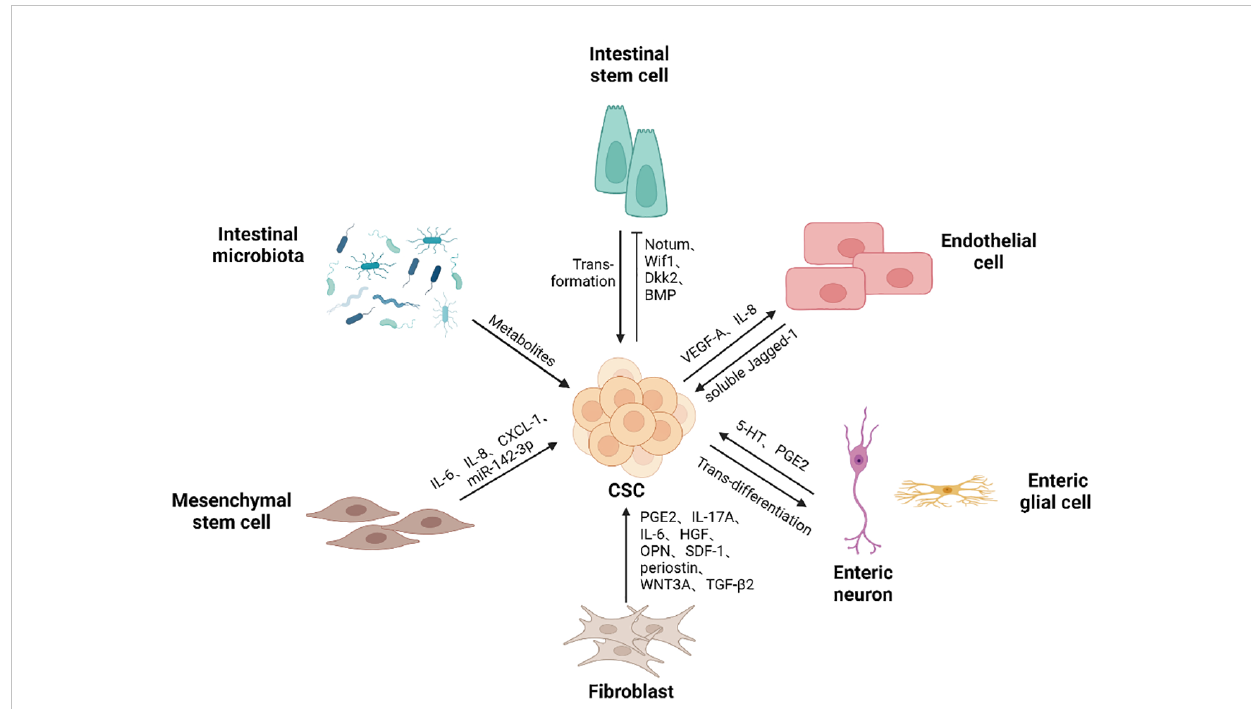
FIGURE 2 Colorectal CSCs niche components. Colorectal CSCs niche contains different types of cells and microbes, as well as the soluble substances they produce, supporting the self-renewal ability of cancer stem cells. Cancer stem cells can gain a competitive advantage over normal stem cells by promoting differentiation. Mutations drive intestinal stem cells to transform into cancer stem cells. Besides, colorectal cancer stem cells promote endothelial cell proliferation and migration, thereby participating in the generation of blood vessels. In addition, cancer stem cells give rise to neurons, thus promoting tumor development. (Created in